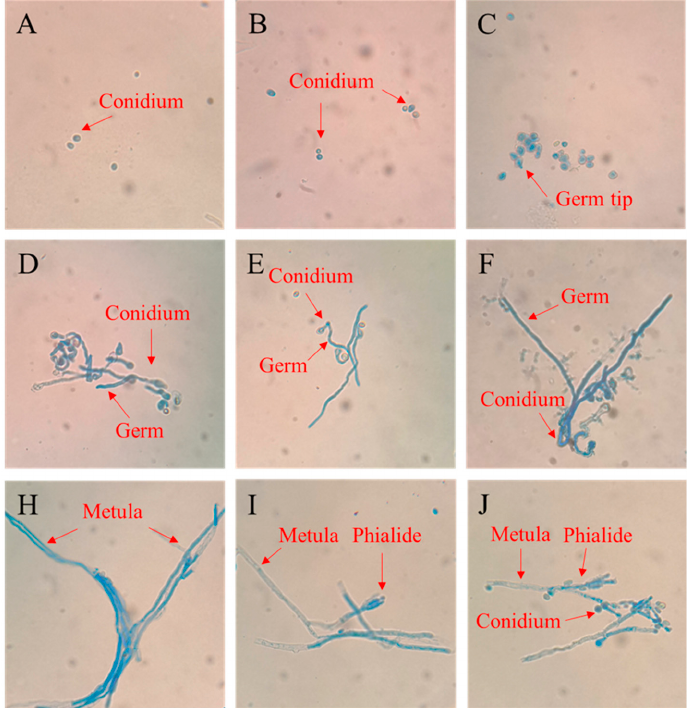
Figure 2. Observation of the growth process of P. digitatum on PDA at 25 °C. ( A – C ) Germination of P. digitatum spores at 0 h, 3 h, 6 h; ( D – F ) growth of P. digitatum in PDA at 9 h, 12 h, 20 h; ( H – J ) growth of P. digitatum in PDA at 28 h, 36 h, 44h. Scale bar represents 20 µm, and is applicable to ( A – J ).